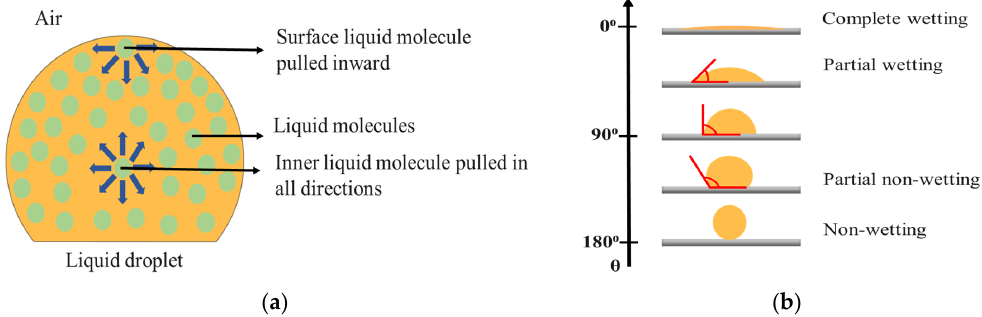
Figure 1. ( a ) Illustration of intermolecular attractive forces in a droplet and ( b ) wetting behavior of liquid drop-based on contact angle.